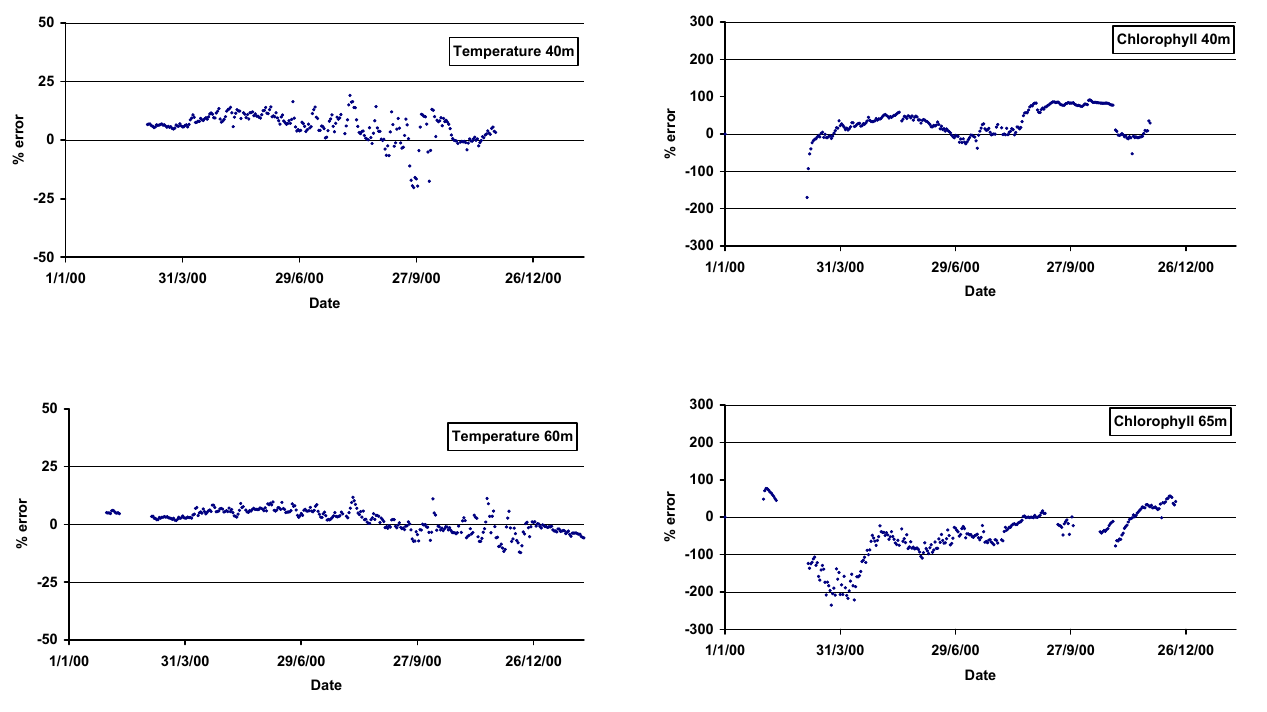
Fig. 9. The percentage error (100*(Data-Model)/Data) for temper- ature at (a) 40m and (b) 60m.